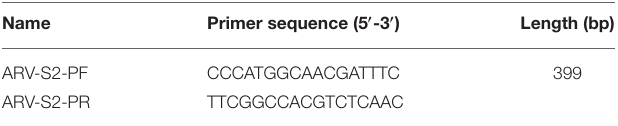
TABLE 1 | Primers for RT-PCR detection of S2 gene of ARV.